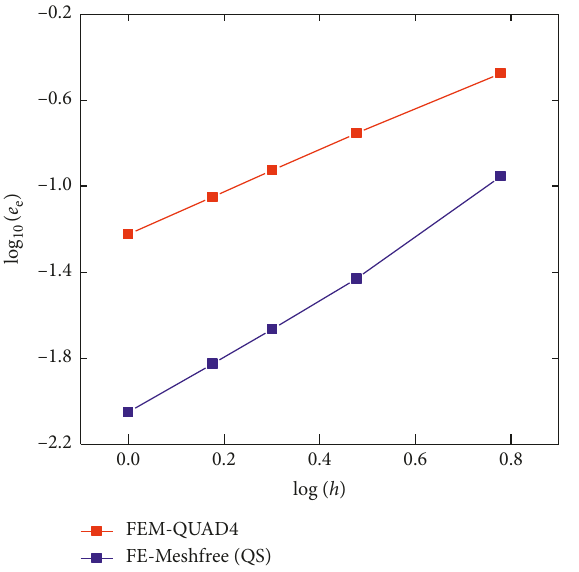
Figure 11: Energy error norm with respect to computation time.